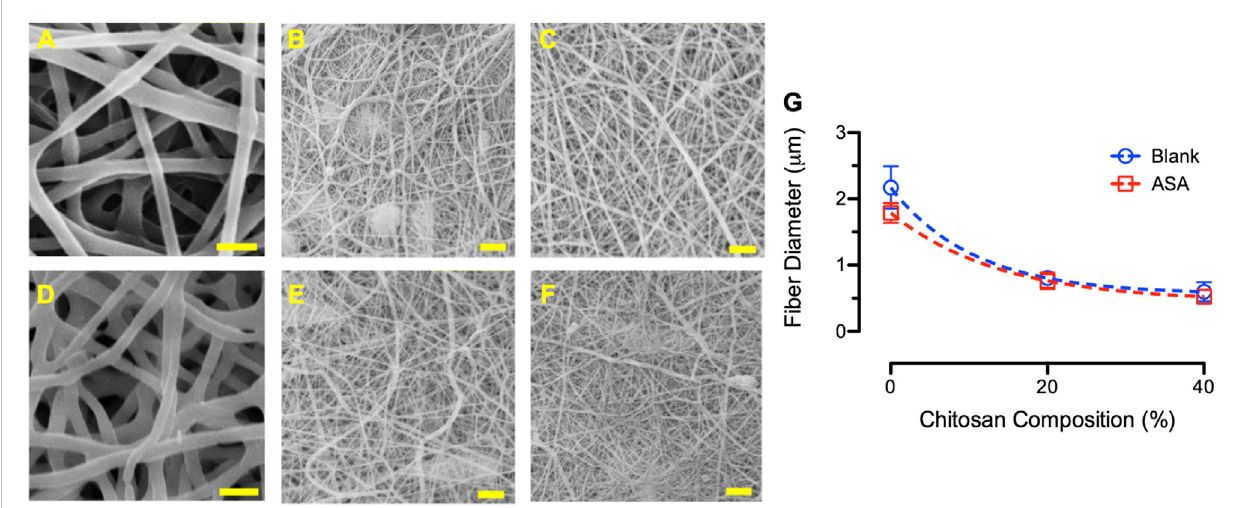
FIGURE 8 SEM images of electrospun PCL/CS fi bers, showing (A) blank 100/0 composition using 15% PCL, (B) blank 80/20 composition using 17.75% PCL, (C) blank60/40compositionusing22.33%PCL, (D) ASA-loaded100/0compositionusing15%PCL, (E) ASA-loaded80/20composition using17.75%, and (F) ASA-loaded 60/40 composition using 22.33% PCL. Scale bar = 5 µm. (G) Average fi ber diameter of blank (blue) and ASA-loaded (red) blend PCL/CS fi bers after modifying the PCL concentrations at various CS compositions.